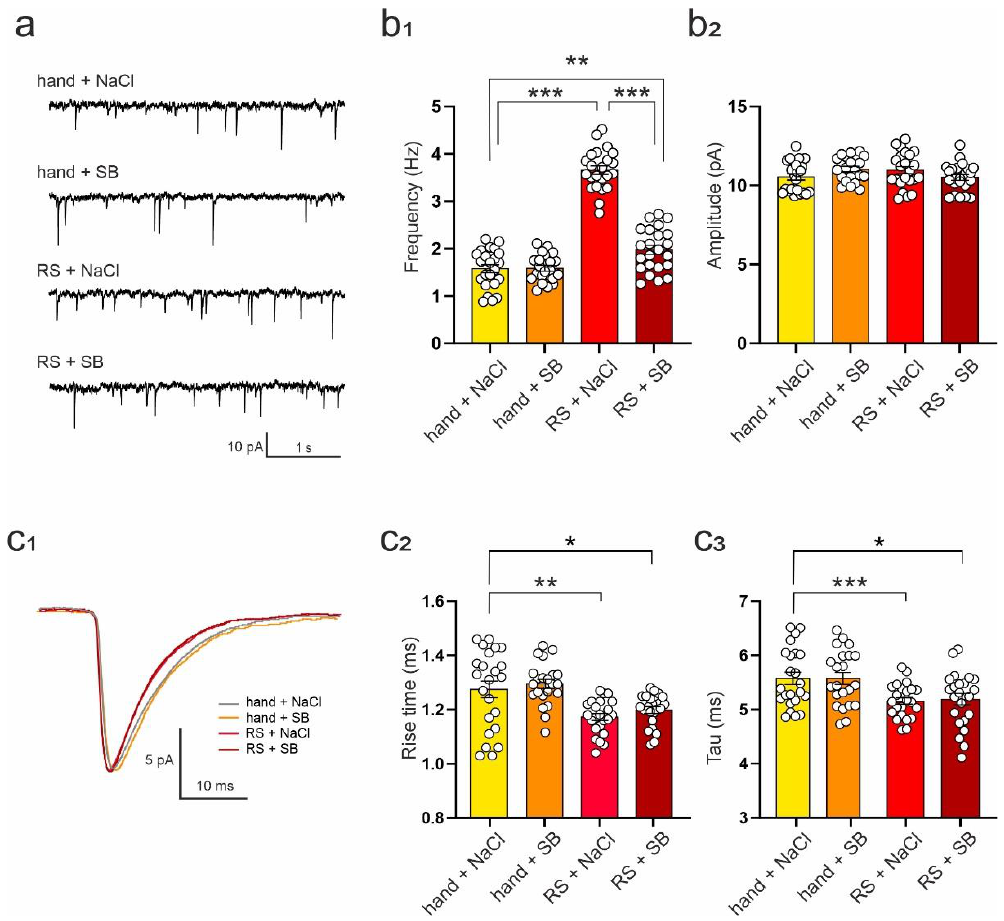
Figure 3. The influence of SB 269970 administration on restraint stress-induced effects on sEPSCs in DRN neurons. ( a ) Sample sEPSC recordings from representative neurons of each group; ( b 1 ) Mean